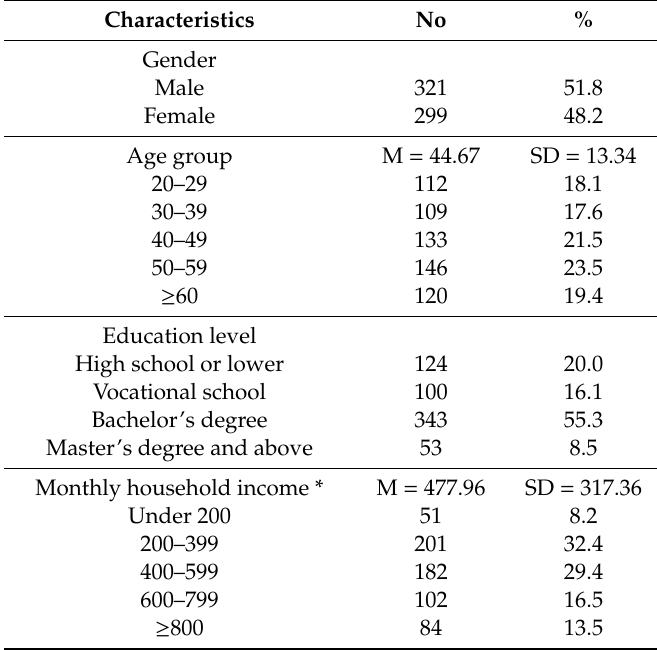
Table 1. Descriptive statistics of survey participants ( n =